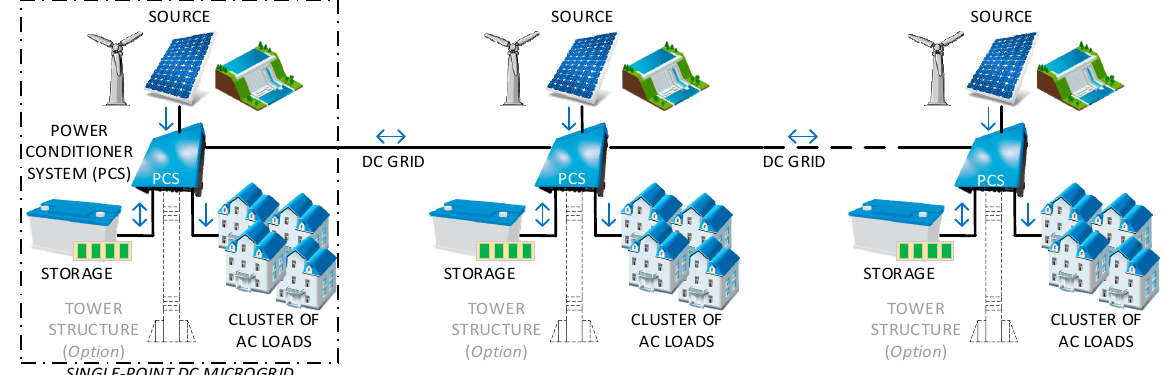
Figure 1. The proposed DC microgrid system.